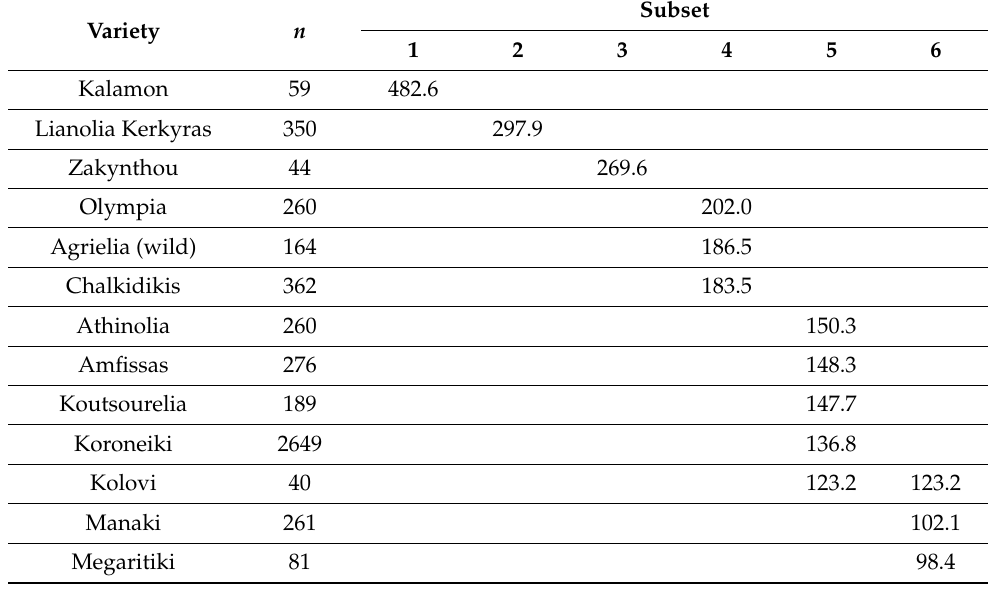
Table 3. Comparisons of oleocanthal means (mg/kg) for each variety using Duncan’s multiple range test ( a = 0.05) (varieties reside in the same subset are not statistically different).